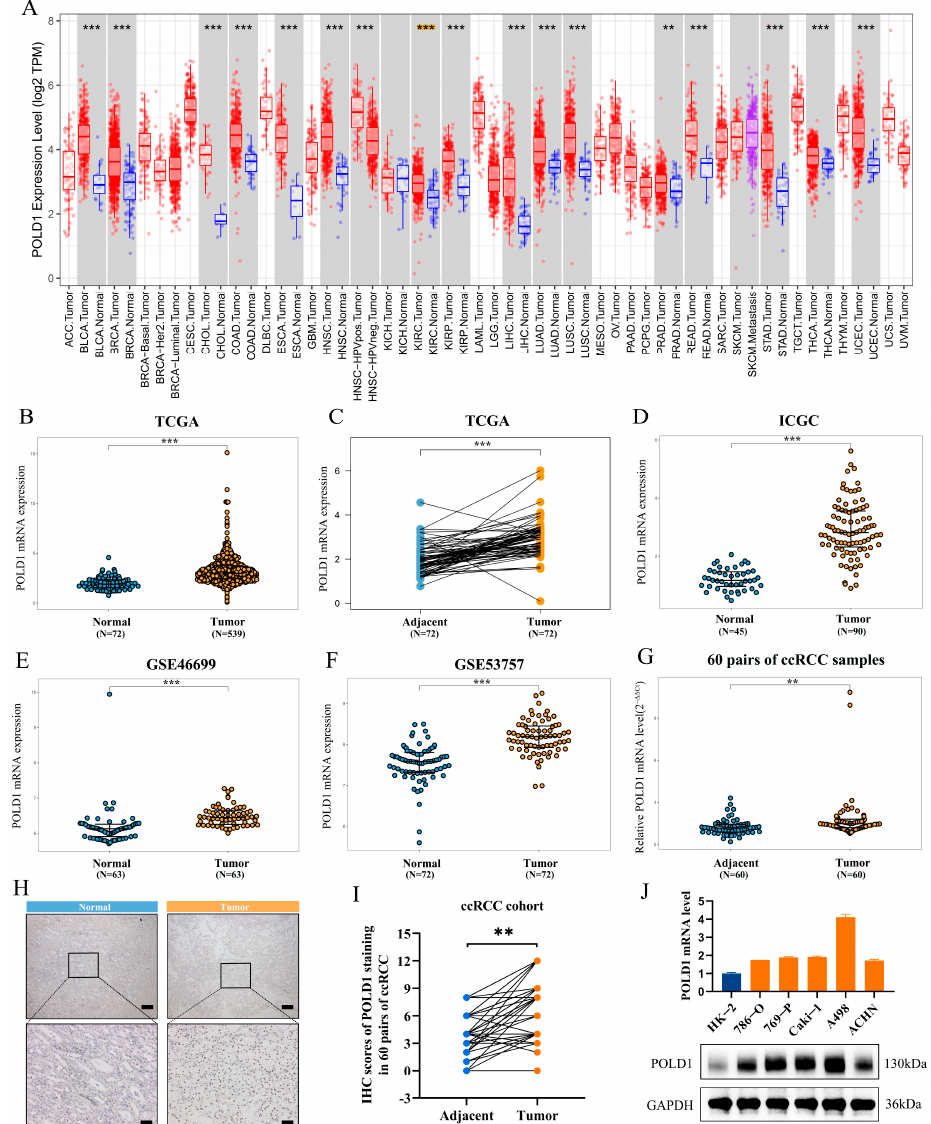
Figure 1. Relationship between POLD1 expression and ccRCC. ( A ) TCGA database analysis showed the POLD1 expression levels in various cancer tissues and their counterpart normal tissues. Yellow background of *** represent KIRC patients. ( B – F ) POLD1 expression levels were significantly higher in the ccRCC tissues compared to the counterpart/paired peritumoral normal renal tissues in the ( B , C ) TCGA, ( D ) ICGC, ( E ) GSE46699 and ( F ) GSE53757. ( G ) The mRNA level of POLD1 in 60 pairs of ccRCC tissues and their paired normal adjacent tissues. ( H , I ) POLD1 IHC staining and statistical results show the protein levels of POLD1 in the validation cohort (scale bar, 50 um; magnification, 100× and 200×). ( J ) The mRNA and protein levels of POLD1 were evaluated in a normal human renal epithelial cell line and RCC cell lines by RT-qPCR and Western blot. Data were shown as mean ± SD. Differences were considered significant at p < 0.05 (** p < 0.01, *** p < 0.001).